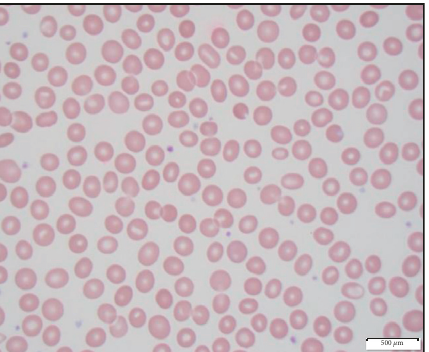
Figure 4: Peripheral smear showing improvement in elliptocytosis after completion of 6 cycles of treatment with